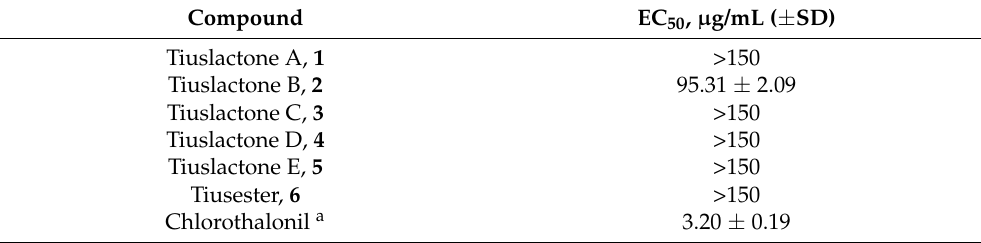
Table 3. Half maximal effective concentration (EC 50 ) values of compounds 1 – 6 on B. maydis.